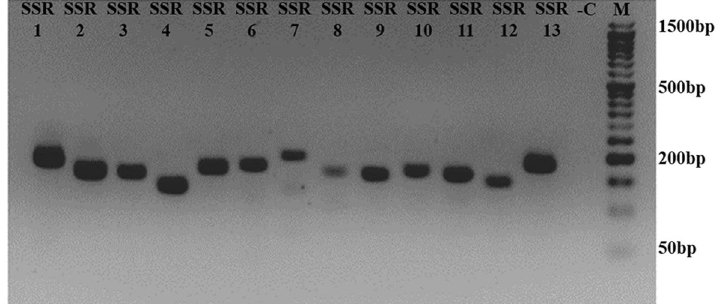
Figure 6. Clinical sample validation using SSR markers. Electrophoresis gel showing the PCR amplicon of the developed SSR markers in ORFV. SSR markers from SSR1 to SSR13; M:50 bp DNA ladder; -C: Negative control (PCR using nuclease-free water as DNA template).